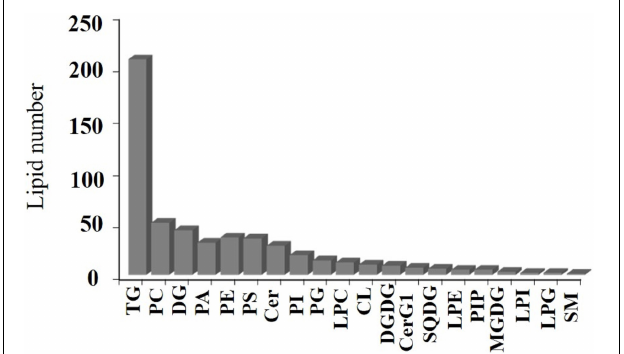
FIGURE 4 | Walnut kernel lipid